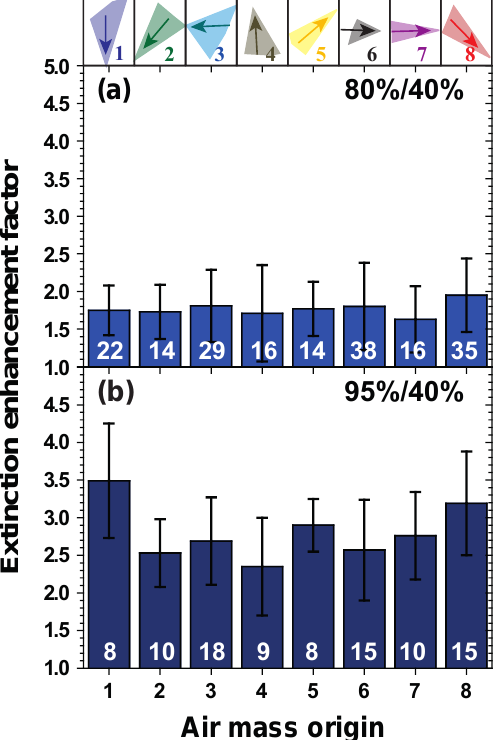
Figure 8. Particle extinction enhancement factors for 550nm (80– 40 and 95–40% RH enhancement) observed from days with occur- ring humidity variations between at least 40 and 80% RH (a) and only from days with variations between at least 40 and 95% RH (b) separated for the eight air-mass transport regimes. The 4-year mean values and SD are